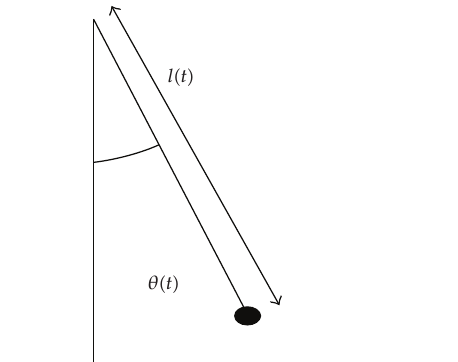
l (cid:4) t (cid:5)